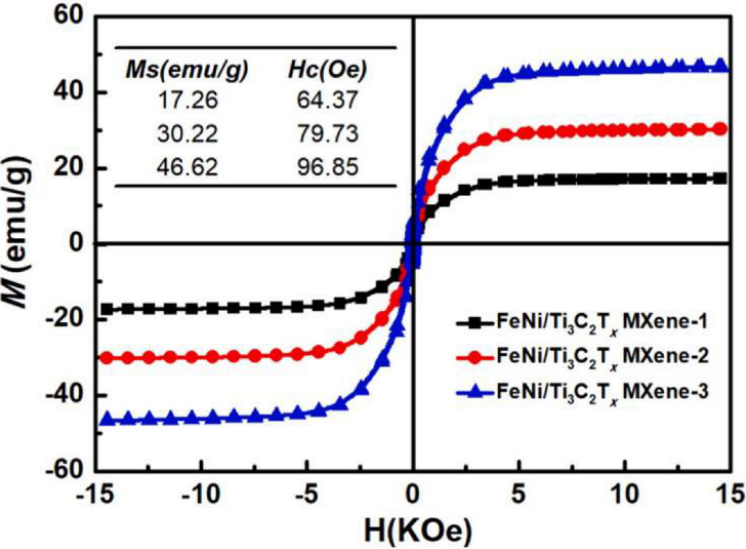
Figure 35. VSM of the as-synthesized FeNi/Ti 3 C 2 T x MXene samples with various FeNi nanoparticle loadings, the inset displays corresponding to M S and H C value [76].